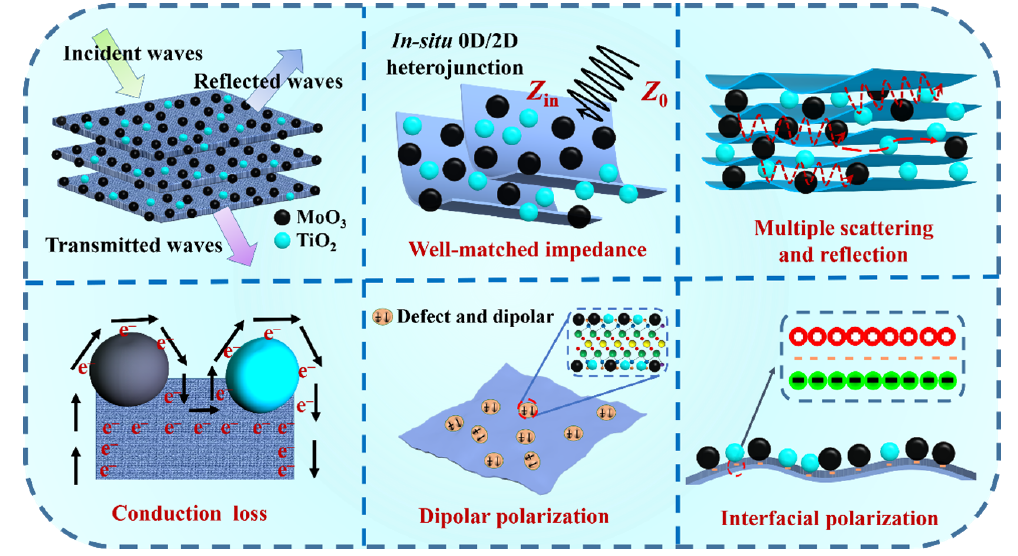
Fig. 9 Schematic illustration of the absorbing mechanism of MoO 3 /TiO 2 /Mo 2 TiC 2 T x